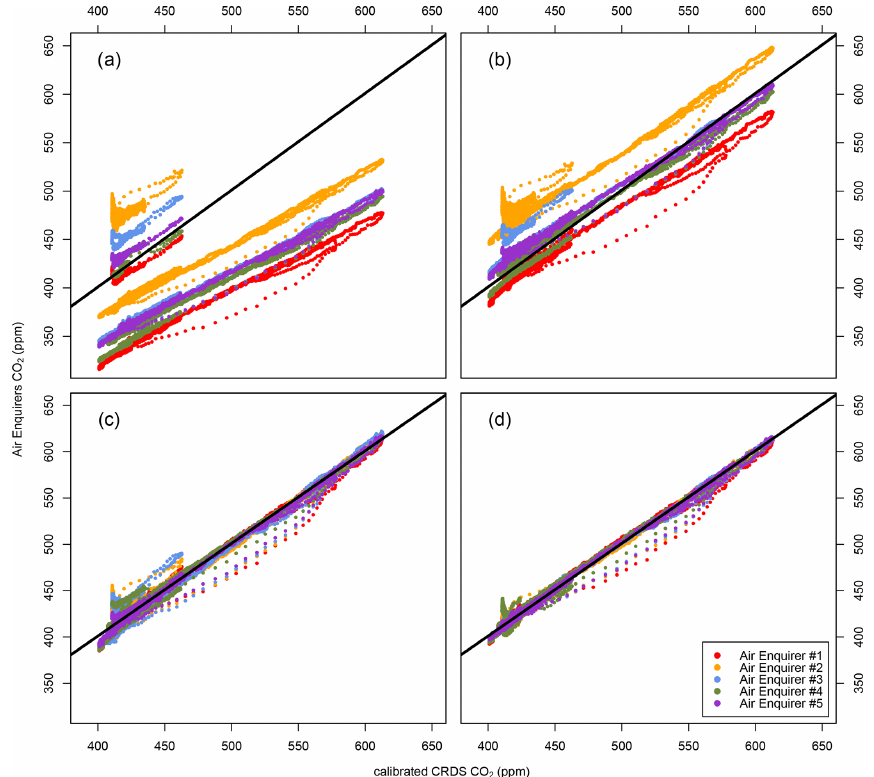
Figure 5. CO 2 concentrations in the air measured by each of the AE sensors during the experiment carried out at the CRAM and IC3 stations vs. CRDS data, using a sensor with raw data (a) , sensor data theoretically corrected by P and RH (b) , sensor data corrected by P and RH and calibrated with the CRDS (c) , and sensor data corrected by P and RH and calibrated using a multiparametric lineal model (d)